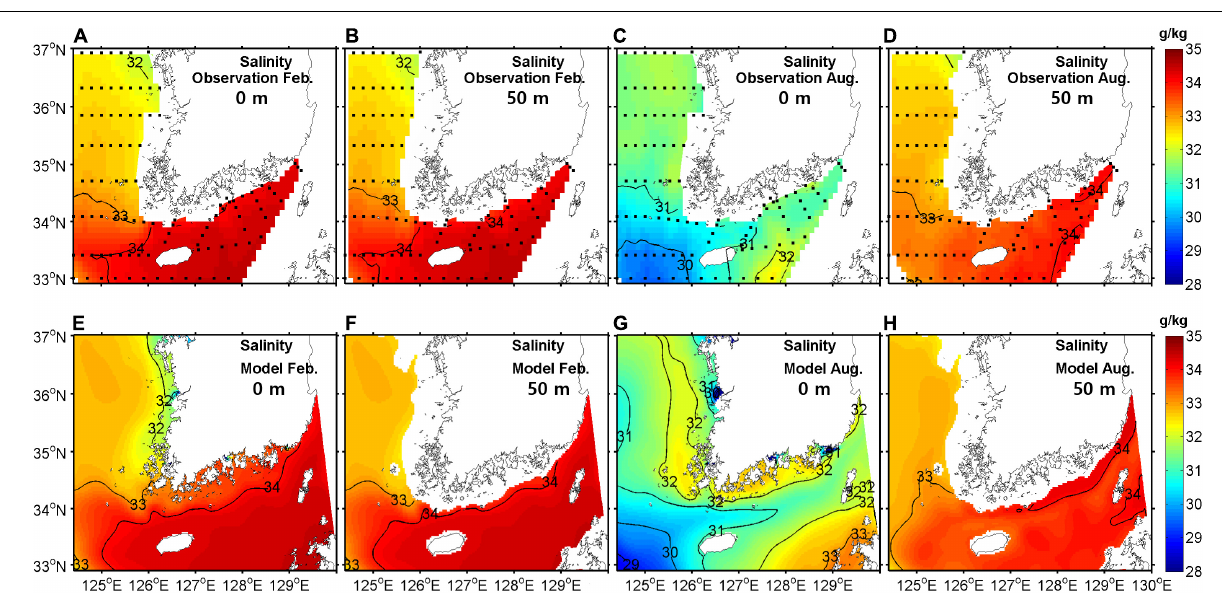
FIGURE 5 | Horizontal distribution of salinity from observations (upper) and model outputs (lower) at the surface (A,C,E,G) and at a depth of 50 m (B,D,F,H) in February (A,B,E,F) and August (C,D,G,H) averaged for the period 2006–2019 (units are g kg − 1